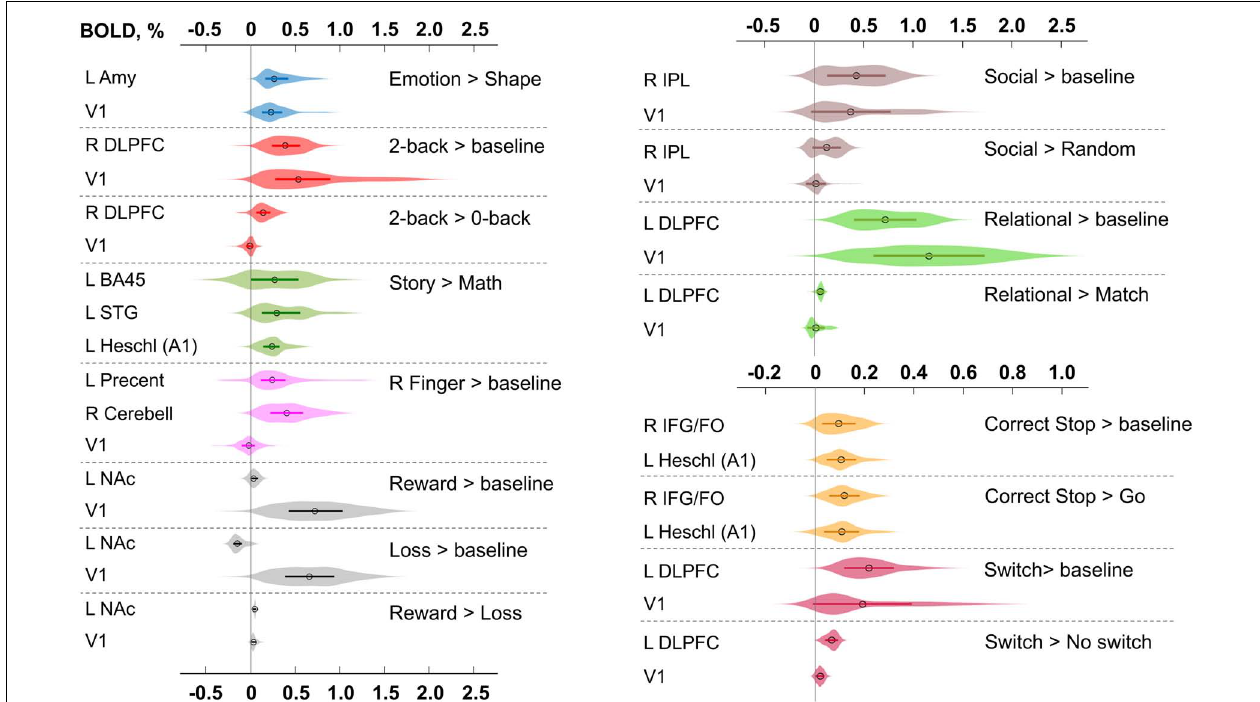
FIGURE 9 | Typical BOLD PSC in fMRI studies. The box plots inside the violins represent the first and third quartile, and the black circles represent median values. Contrasts from the same task are indicated in one color. L/R, left/right; AMY, amygdala; V1, primary visual cortex; DLPFC, dorsolateral prefrontal cortex; BA, Brodmann area; STG, superior temporal gyrus; A1, primary auditory cortex; NAc, nucleus accumbens; IPL, inferior parietal lobule; IFG/FO, inferior frontal gyrus/frontal